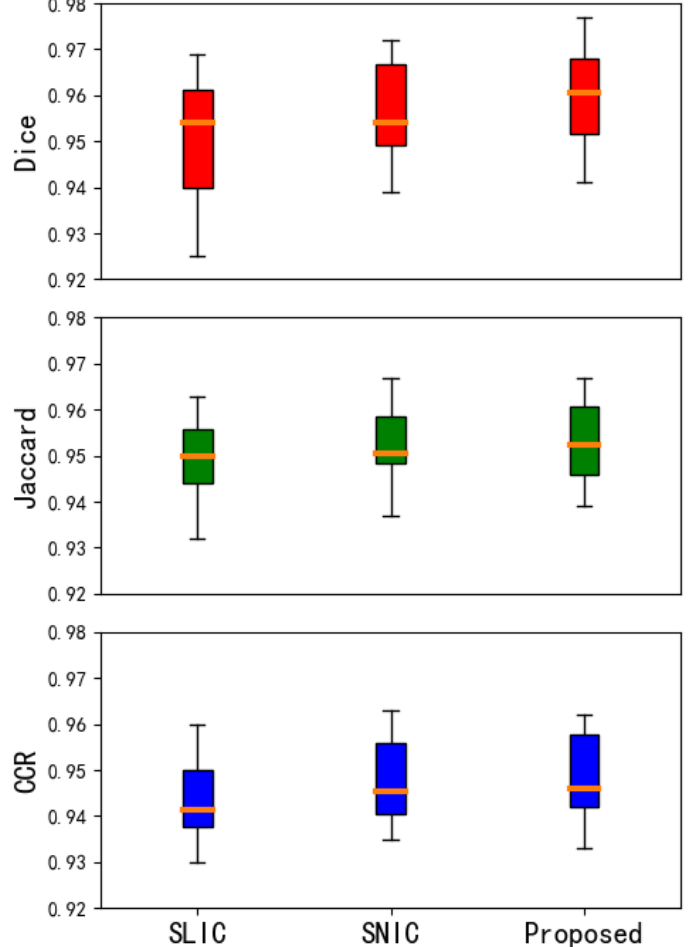
Figure 12. Box chart of evaluation index. The above three pictures respectively Dice , Jaccard , and Correct classification ration ( CCR ) of SLIC (first column), SNIC (second column) and Proposed method (third column),